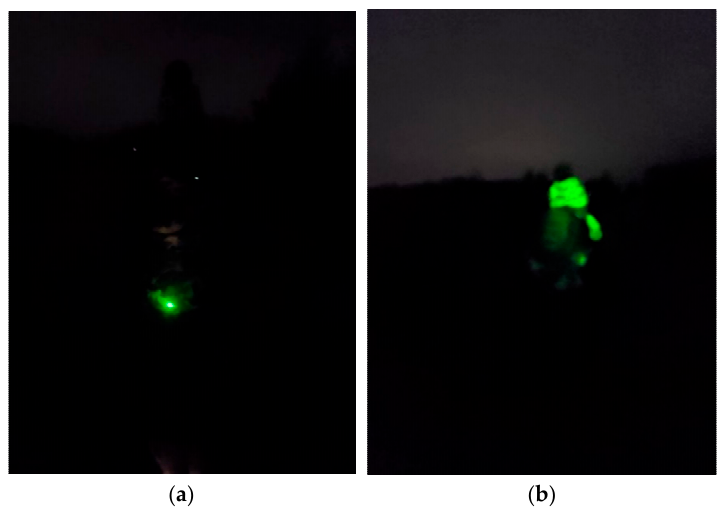
Figure 8. Impression of the size of the laser beam from distances of 100 m ( a ) and 1100 m ( b ).